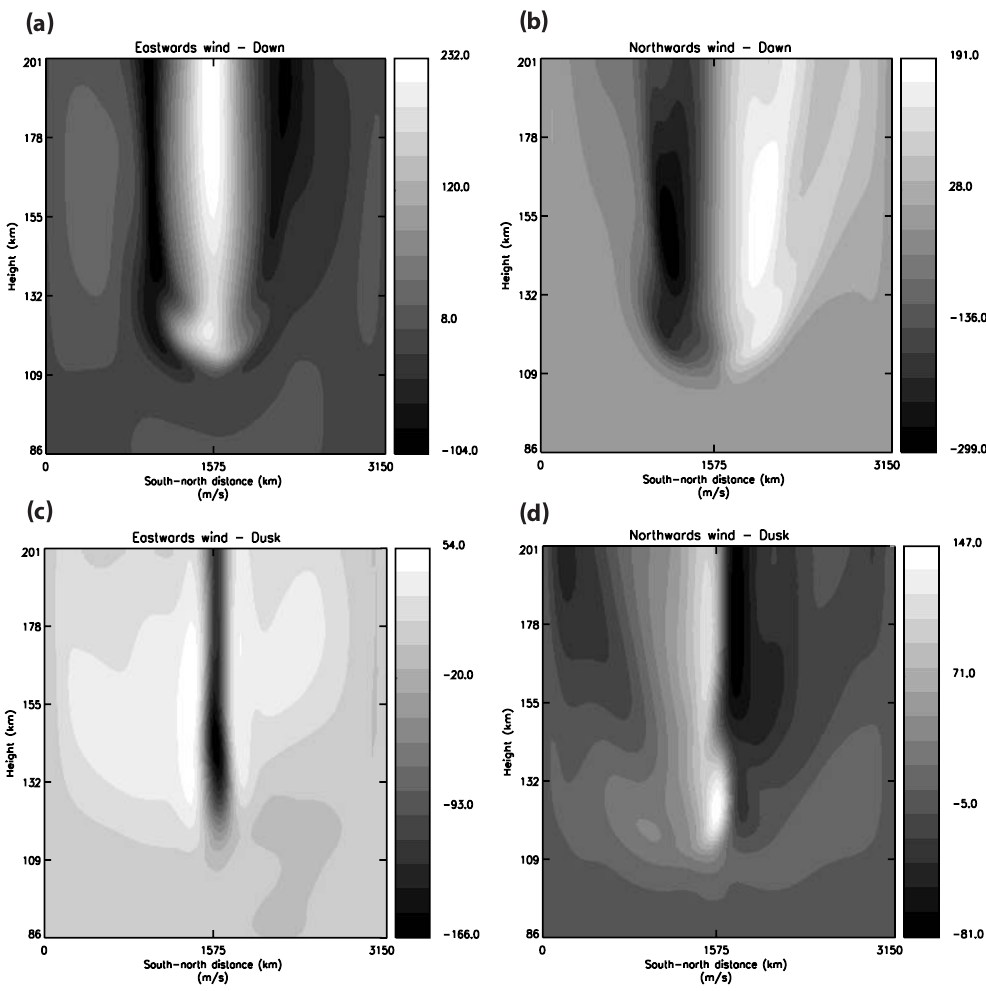
Fig. 1. Contours of simulated neutral winds versus south-north distance and height, plotted at the center of the longitudinal domain, for equivalent conditions on the dawn and dusk